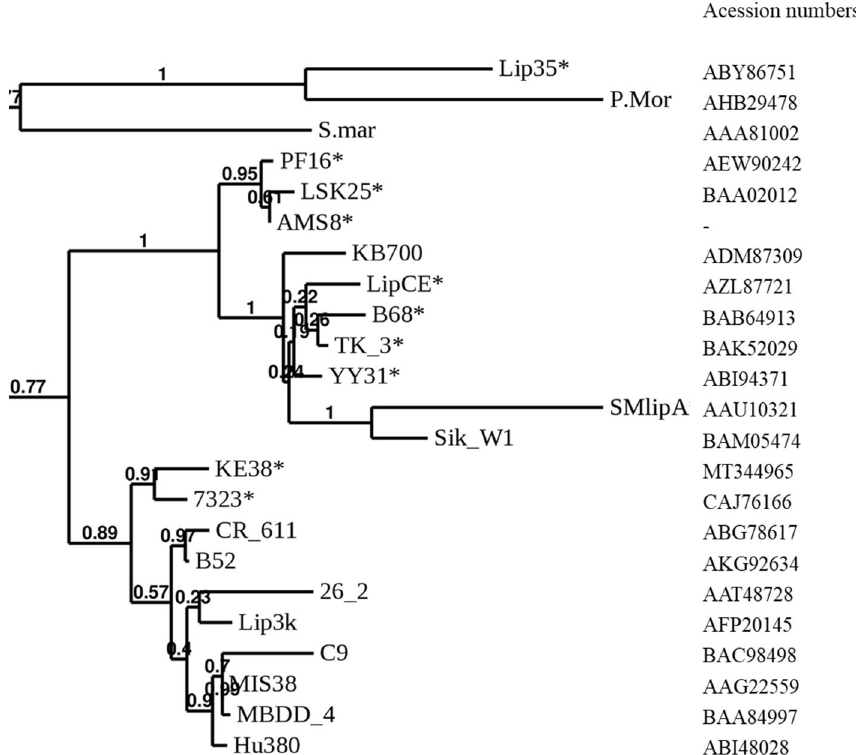
Figure 4. Phylogenetic tree showing the evolutionary relatedness of KE38 lipase with other lipases belonging to family I.3. *Represents cold-active lipases. Bootstrap probabilities are shown on the tree.